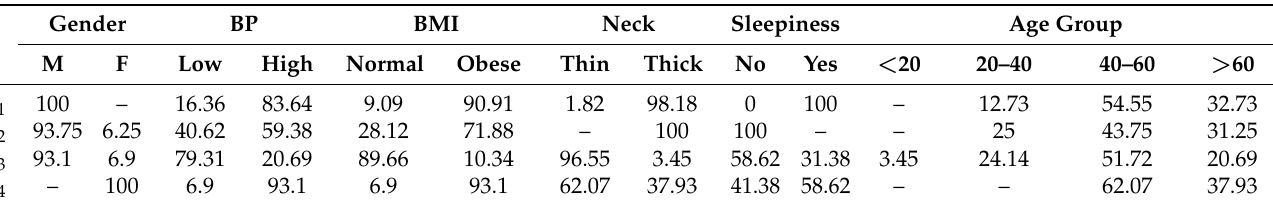
Table 4. Anthropometric measurements for each of the four communities C 1 – C 4 classified in each corresponding binary category. The values indicate the percentages of the patients from each community.